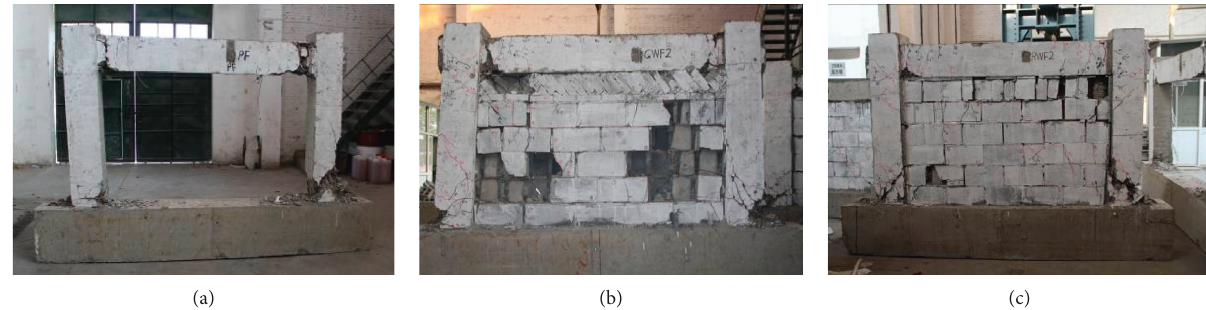
Figure 8: Final failure modes of three specimens provided by reference [11]: (a) bare frame; (b) infilled RC frame with rigid connection; (c) infilled RC frame with flexible